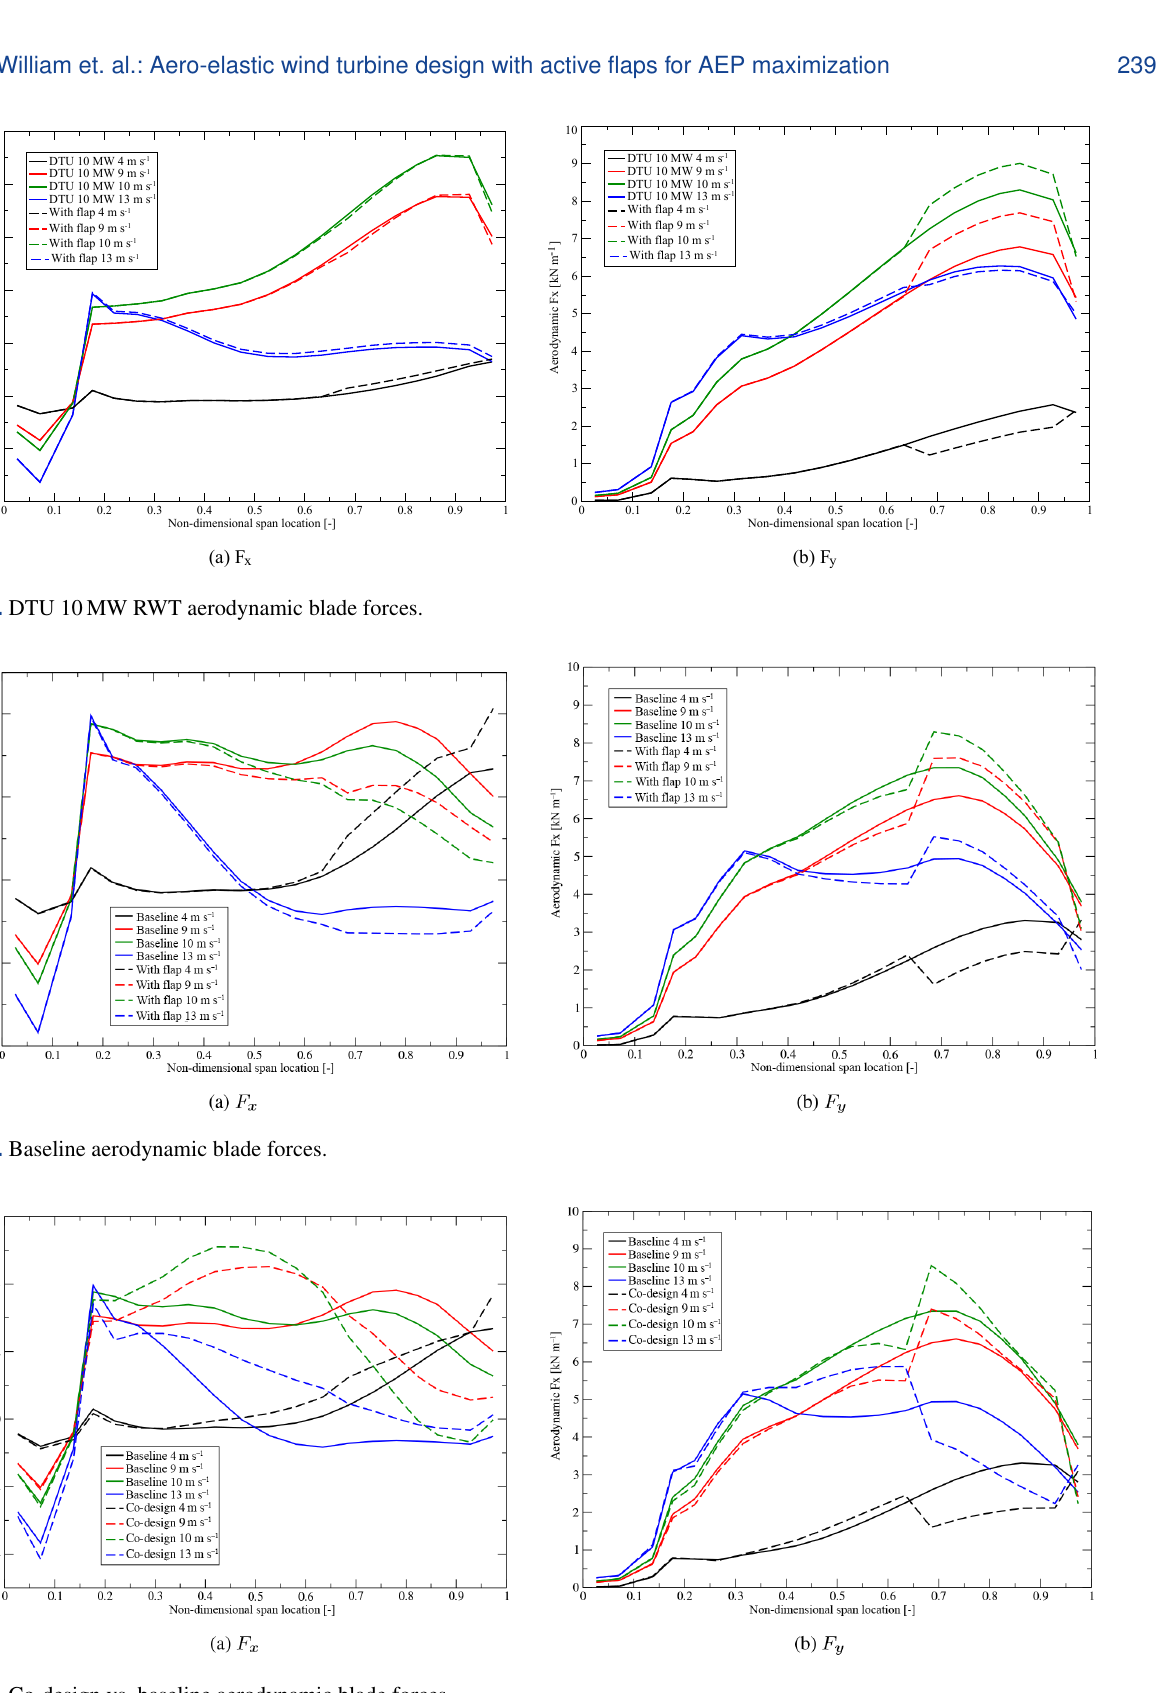
Figure 12. Co-design vs. baseline aerodynamic blade